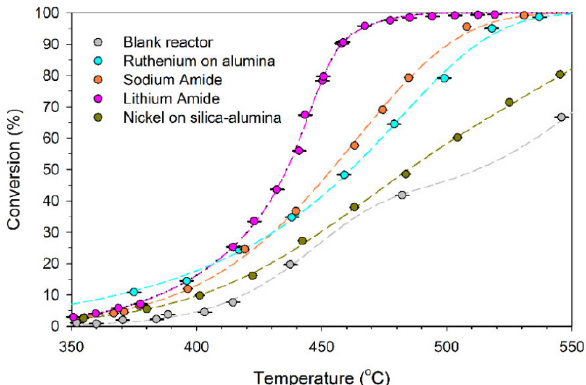
Figure 39. Comparison of catalytic activities of metal amides with supported nickel and ruthenium catalysts at 580–600 °C. Reprinted with permission [136].